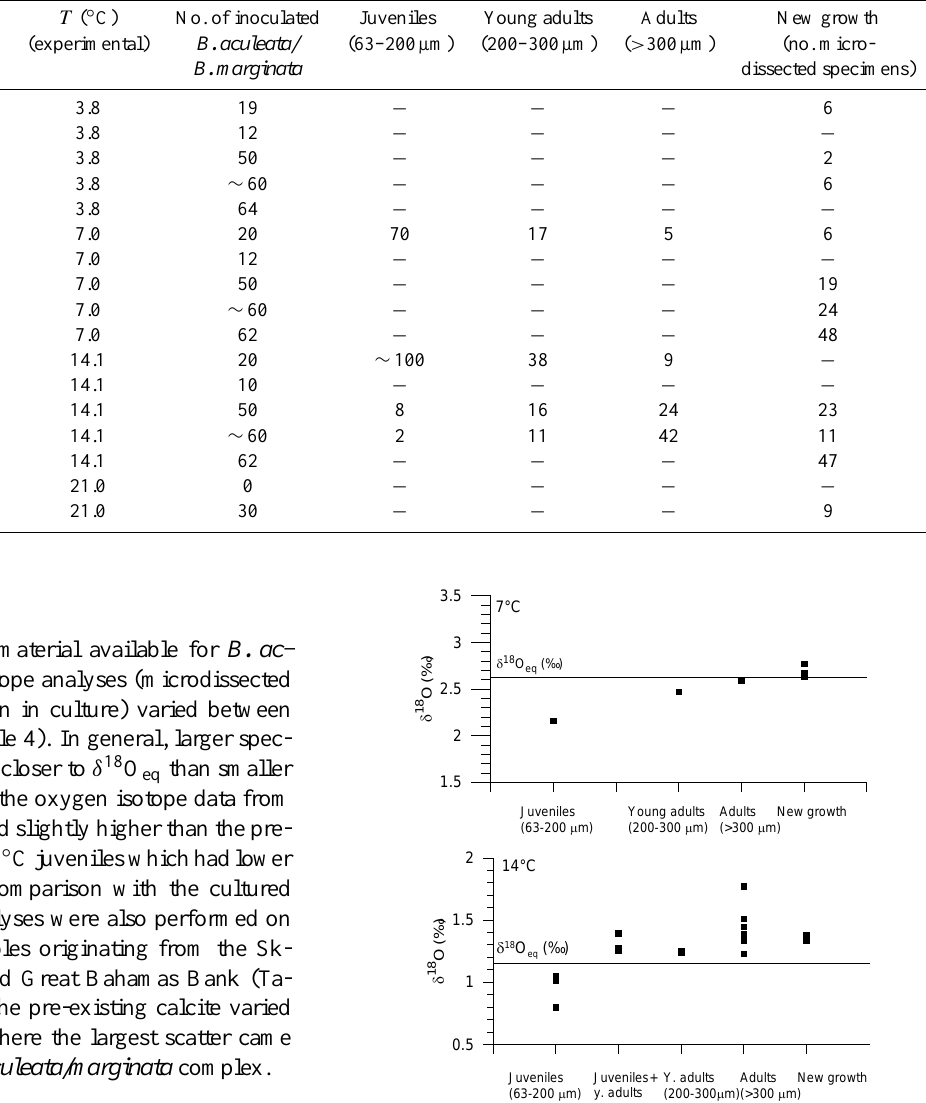
Table 3. Number of inoculated specimens from the different source regions together with the results from the culturing experiment, organized according to temperature and size classes. “Monoculture” refers to monocultures of Bulimina aculeata/marginata , originating from the Charleston Bump and near the Great Bahama Bank. Juveniles, young adults, and adults were born in culture; “new growth” is material precipitated during the experiment.